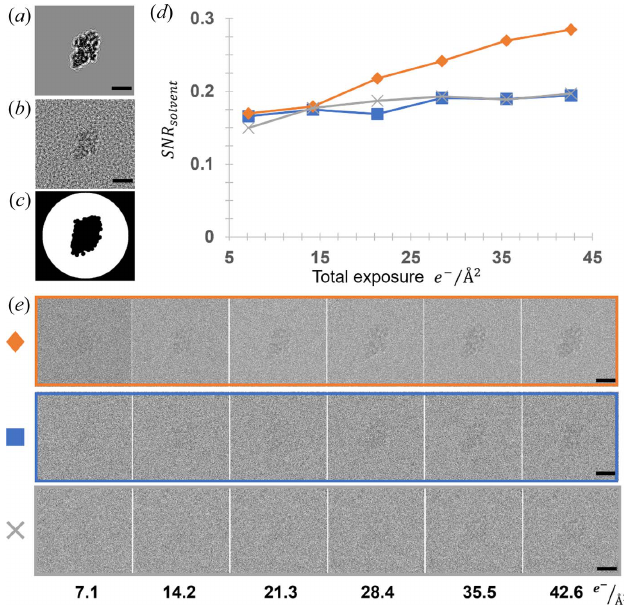
Figure 5 Comparison of the continuum and coarse-grained all-atom solvent model with the experimental data. ( a ) j detector j 2 with a constant potential added for the solvent. ( b ) j detector j 2 with coarse-grained all-atom water model. The average intensity in ( a ) and ( b ) in the solvent region is identical within numerical precision. ( c ) Mask used in calculating SNR solvent [Equation (2) main text] where the white region was used for the solvent, and the central black region for the protein. ( d ) Plot of SNR solvent as a function of accumulated exposure for experimental data (blue line, square marker), coarse-grained all-atom solvent model (gray, x marker) and constant solvent potential (orange diamond marker). ( e ) Images used in calculating the plot in ( d ) with the same color/marker scheme, and the total exposure is indicated along the bottom. Experimental data taken from EMPIAR 10061, beta-galactosidase. Scale bar 100 A˚